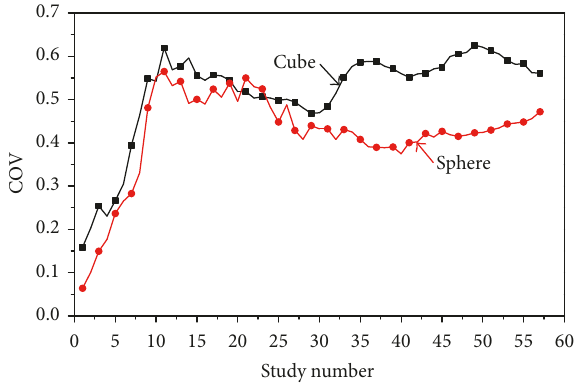
Figure 13: COV comparison of cubic and spherical